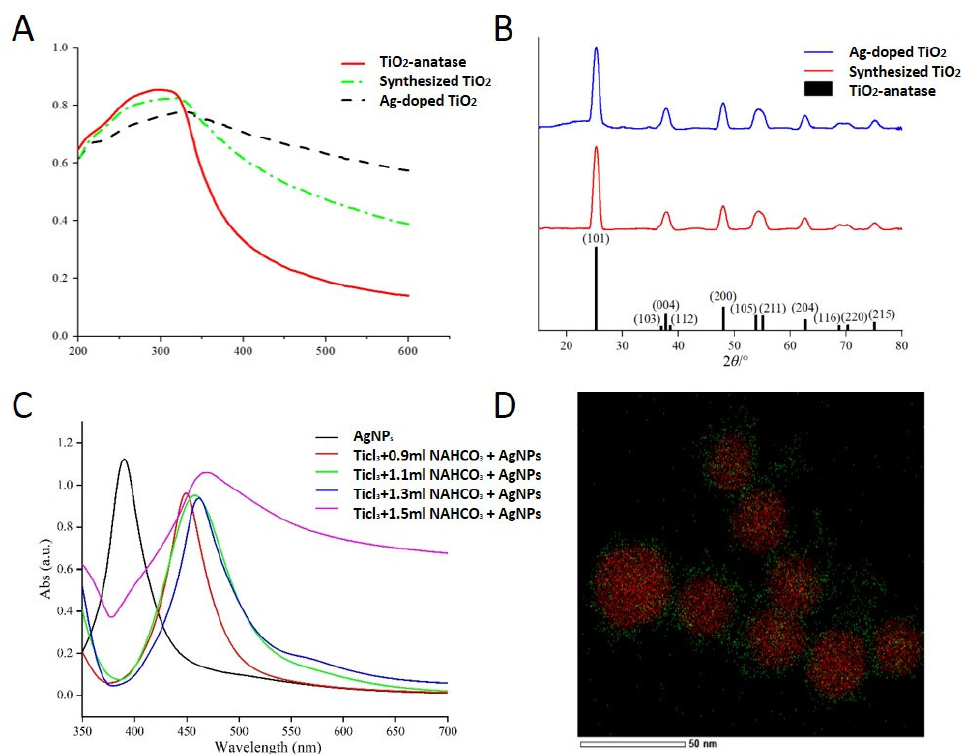
Figure 2. Properties of Ag-modified TiO 2 . ( A ) UV-vis absorption spectra of Ag-doped TiO 2 compared with commercially available TiO 2 (P25) and the synthesized TiO 2 ; ( B ) XRD of Ag-doped TiO 2 compared with P25 and the synthesized TiO 2 ; ( C ) UV-vis absorption spectra of Ag-core TiO 2 with the different thickness of the shell; ( D ) TME-EDS of Ag-core TiO 2 .